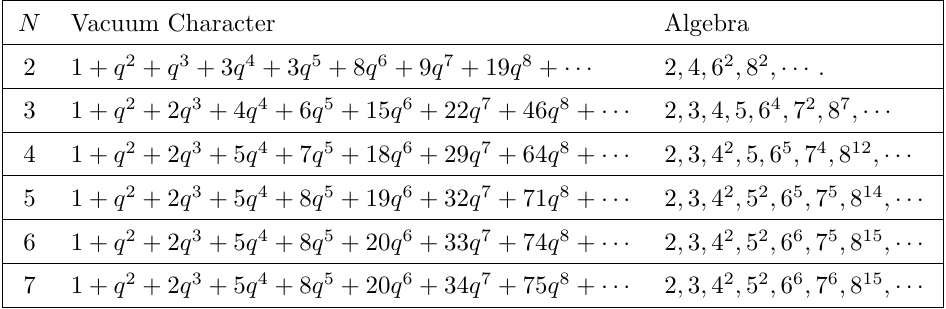
Table 1 . The vacuum character for the stringy coset model for small values of N . The corre- sponding algebra appears in the third column. The central charge of the coset is related to N by c = N 2 1. Note that the vacuum character (and hence the algebra) stabilizes till order q N : which (cid:0) means that the generators up to spin N do not change on further increasing N